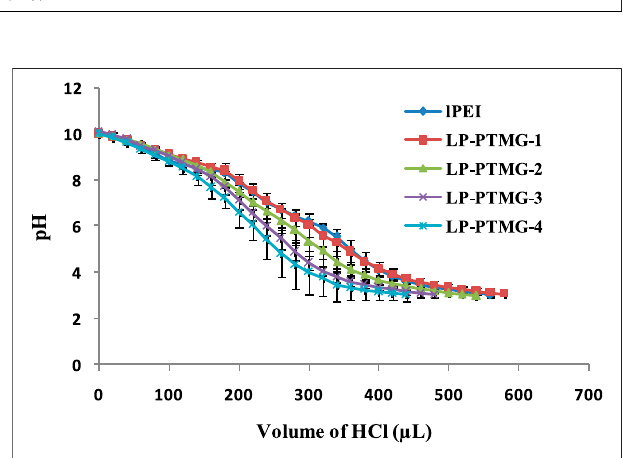
FIGURE 2 | pDNA retardation assay of lPEI/pDNA and a series of LP-PTMG/pDNA polyplexes.